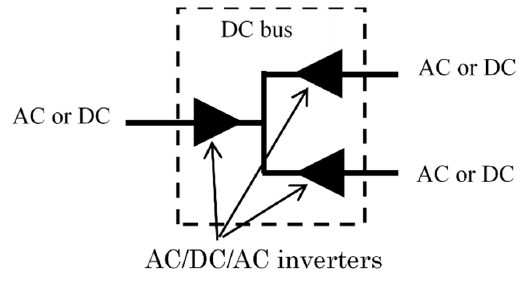
Figure 2. Structure of the digital grid router.